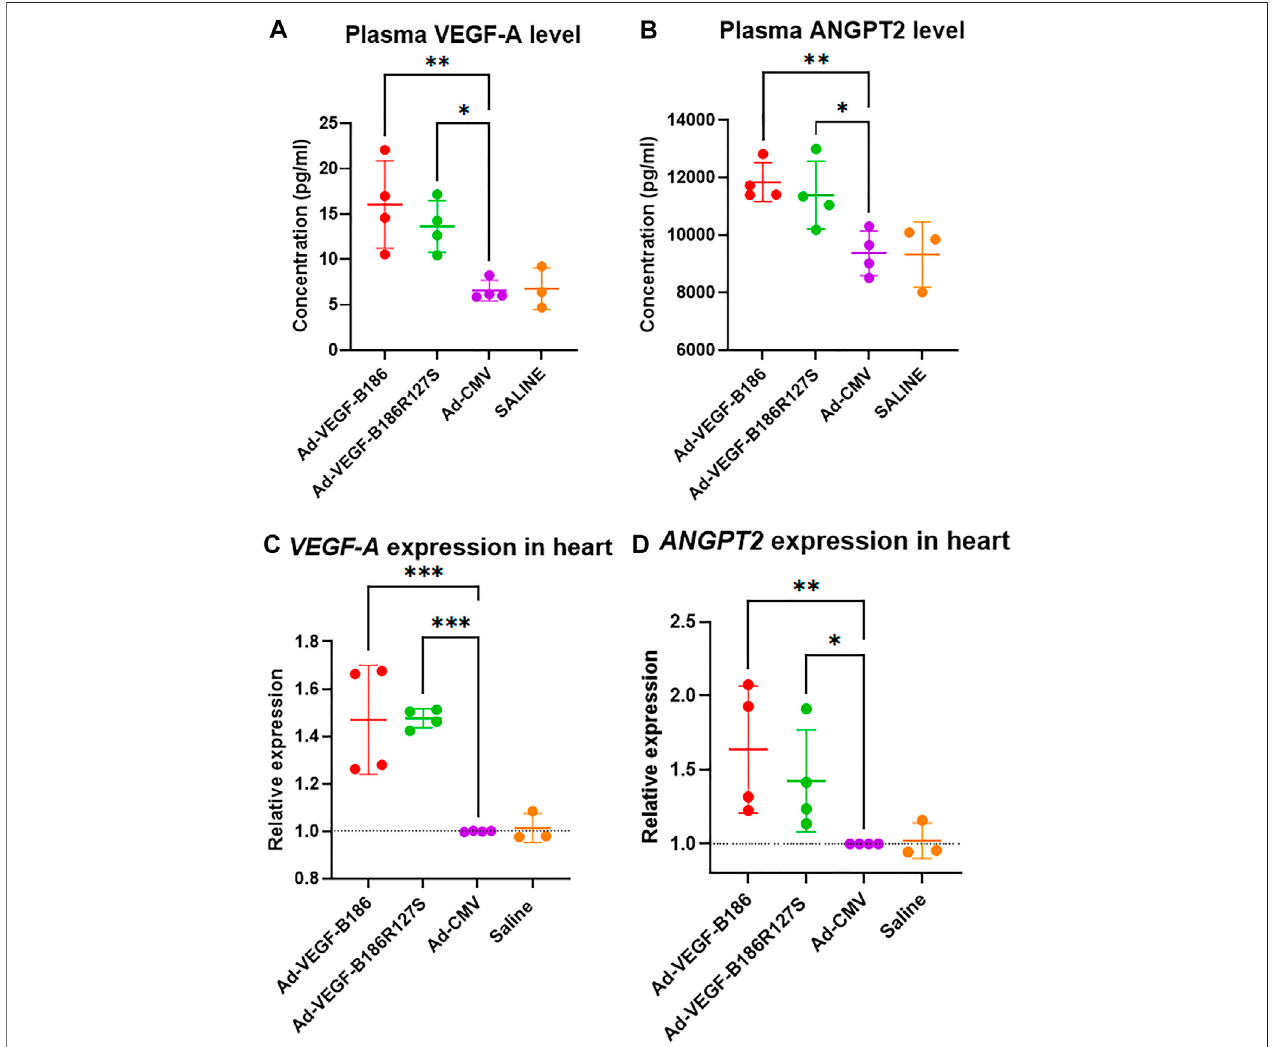
FIGURE 3 | VEGF-B186R127S upregulates VEGF-A and ANGPT2 expression. (A and B) Comparison of plasma VEGF-A and ANGPT2 levels 6 days after gene transfer. (C and D) Comparison of VEGF-A and ANGPT2 expression inheart6 daysfollowinggenetransfer.Eachdotindicates onemouse; n =4inAd-VEGF-B186, n